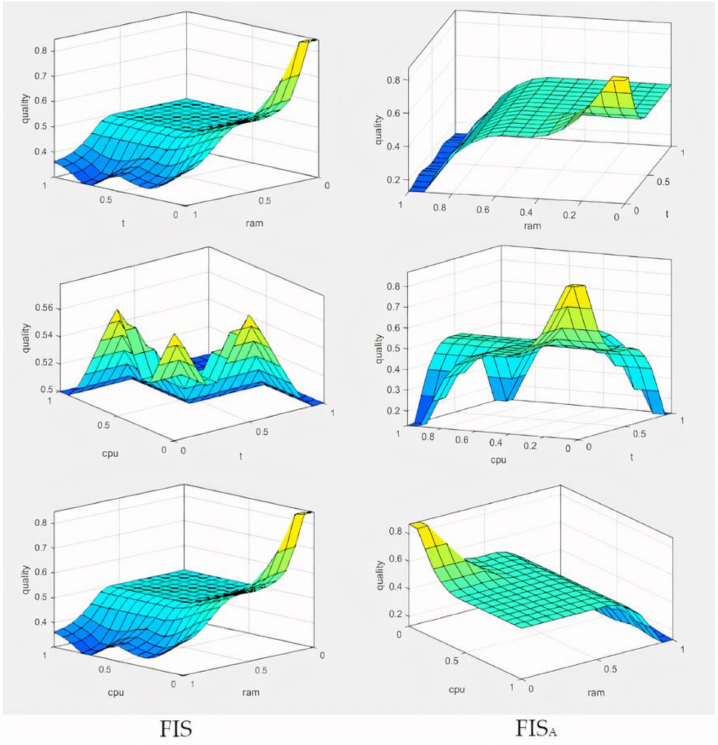
Figure A3. Decision surfaces for fuzzy inference systems, FIS and FIS A . Consideration of decision surfaces for pairs of indicators for FIS and FIS A indicates the applicability of both fuzzy inference systems for the choice of information technology solutions. However, due to a more compact rule base and the use of weight priorities, FIS is distinguished by a higher steepness of the surface in terms of t , cpu and by the presence of local maximum, which is compensated by the superior weight of the selection rules in terms of the ram indicator (Rules 10 and 11) to eliminate the ambiguity of the choice in terms of t , cpu